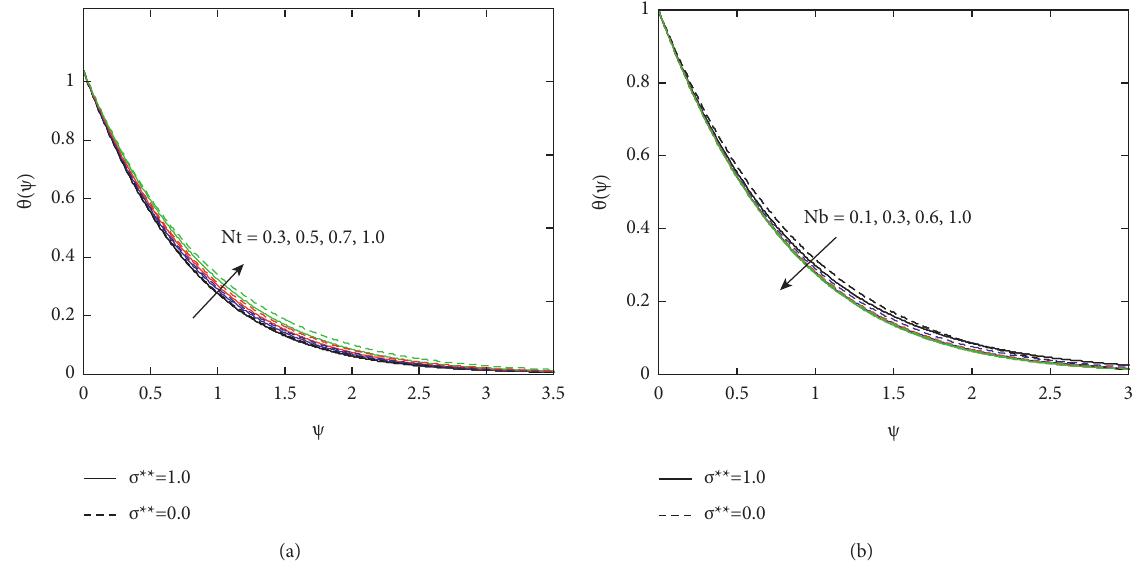
Figure 5: The temperature distribution for diverse quantity of Nt (a) and Nb (b).